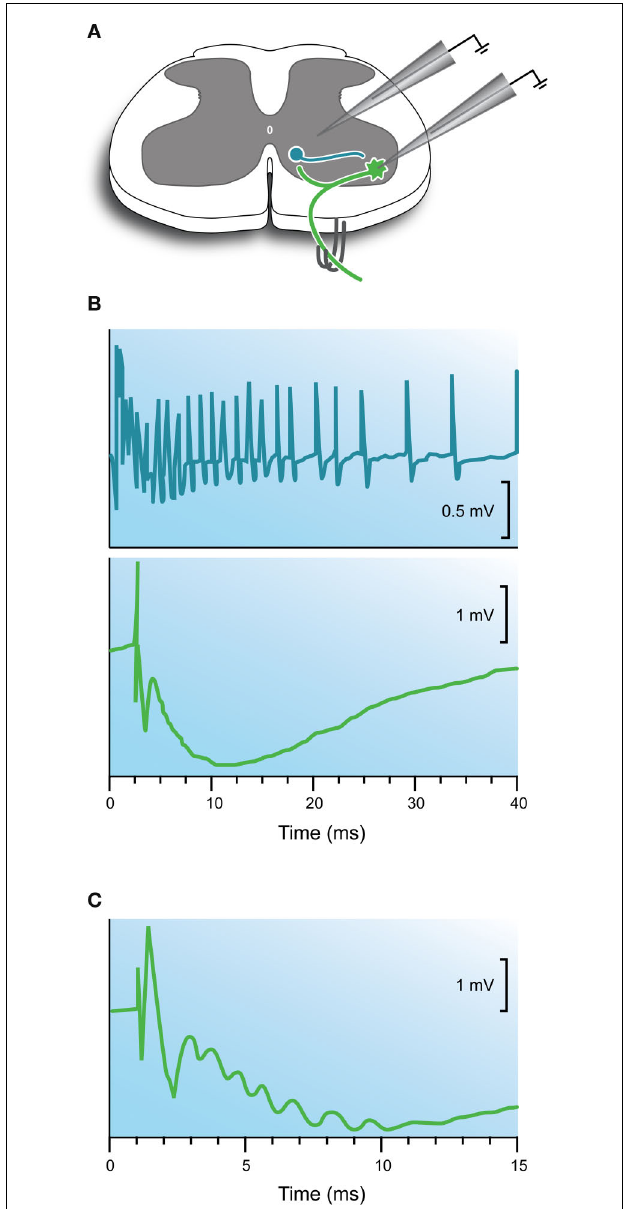
FIGURE 4 | Electrophysiological features of the recurrent inhibitory pathway. (A) Schematic showing the Renshaw cell circuit and recording methods. The recurrent pathway is activated by stimulating muscle nerves or ventral roots in deafferented preparations. In some experiments extracellular recordings are made from Renshaw cells located on the ventro-medial border of the ventral horn. In other experiments intracellular recordings are made from motoneurons. (B) Upper trace shows the extracellular response in a Renshaw cell following a single ventral root volley. Note the prolonged discharge. Lower trace shows an intracellularly recorded response in a motoneuron after a single ventral root volley. Note the long time course of the hyperpolarization compared with the response observed after stimulation of the reciprocal inhibitory pathway ( Figure 2C ). (C) Response shown in panel (B) lower on an expanded timescale. Note the prominent “ripples” in the rising phase of the hyperpolarization indicating the arrival of multiple high frequency inhibitory inputs from Renshaw cells. Modifi ed with permission from Figures 3 and 12 in Eccles et al.